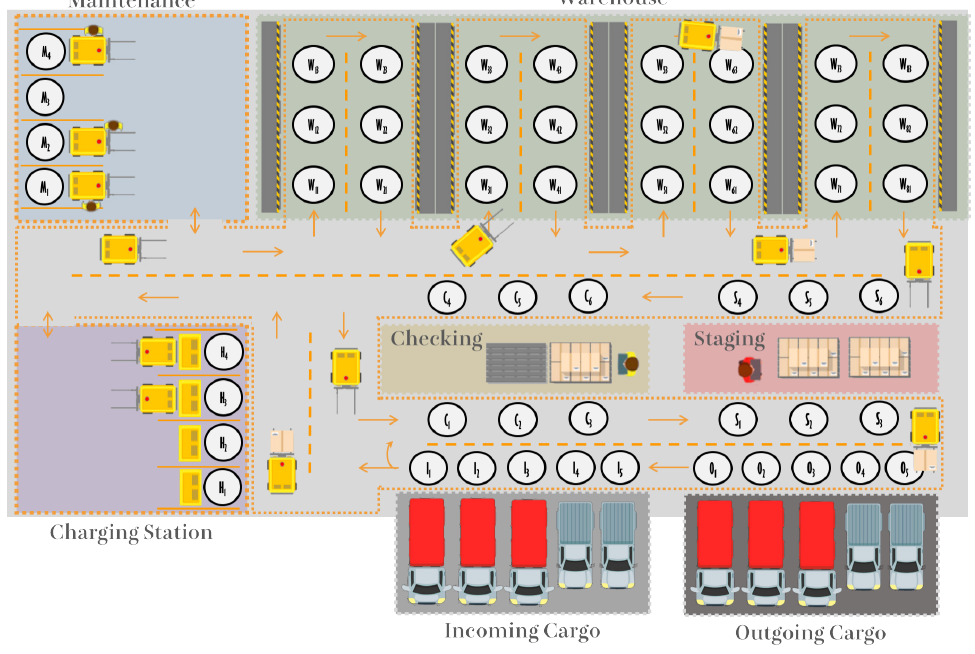
Figure 9. Warehouse logistics organization